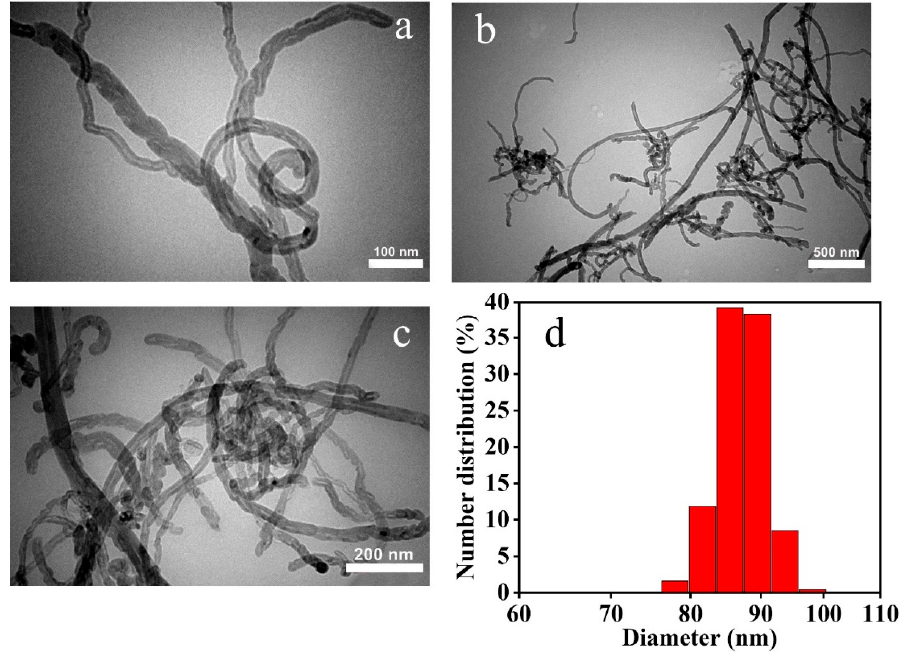
Figure 2. TEM images of MWCNTs ( a ), γ -Fe 2 O 3 /MWCNTs ( b ), and γ -Fe 2 O 3 /MWCNTs/Ag NC particles ( c ). ( d ) Particle size distribution of the γ -Fe 2 O 3 /MWCNTs/Ag NC particles. The FESEM images of γ -Fe 2 O 3 /MWCNTs and γ -Fe 2 O 3 /MWCNTs/Ag NC particles are